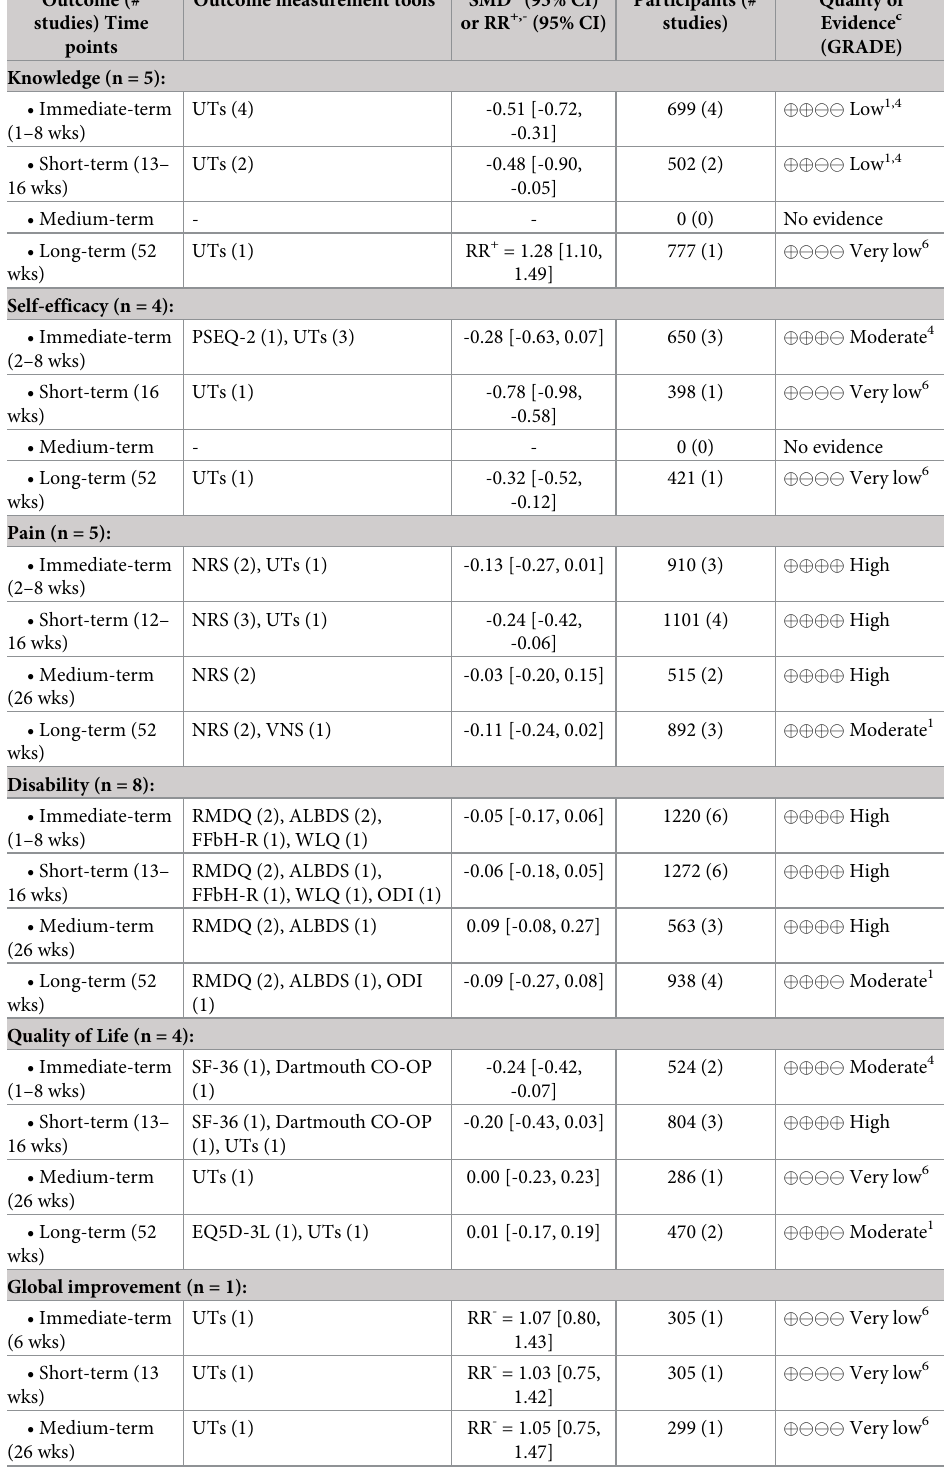
Table 4. Summary of findings: Education materials compared with no intervention (usual care) for acute/sub- acute low back